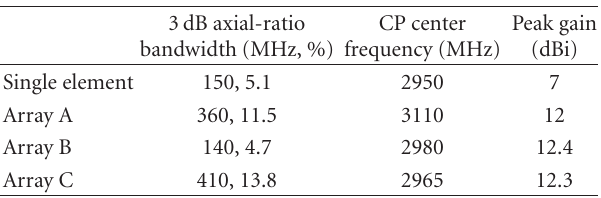
Table 1: Experimental results for the studied single element and array